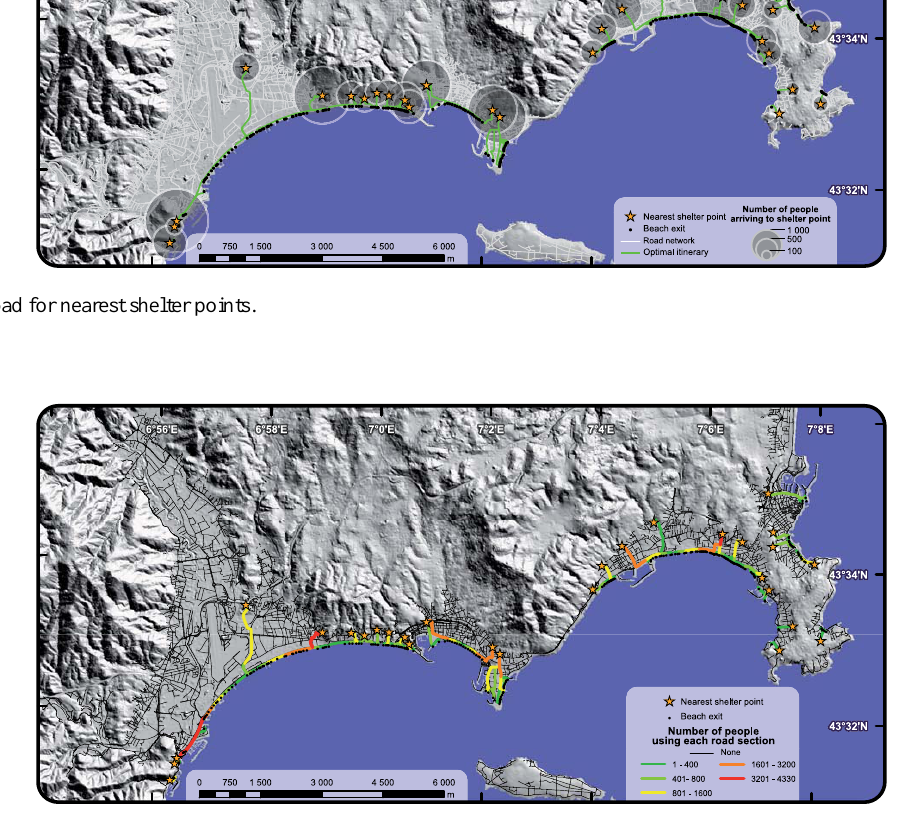
Fig. 9. Shelter entrance points and charge for evacuation routes.